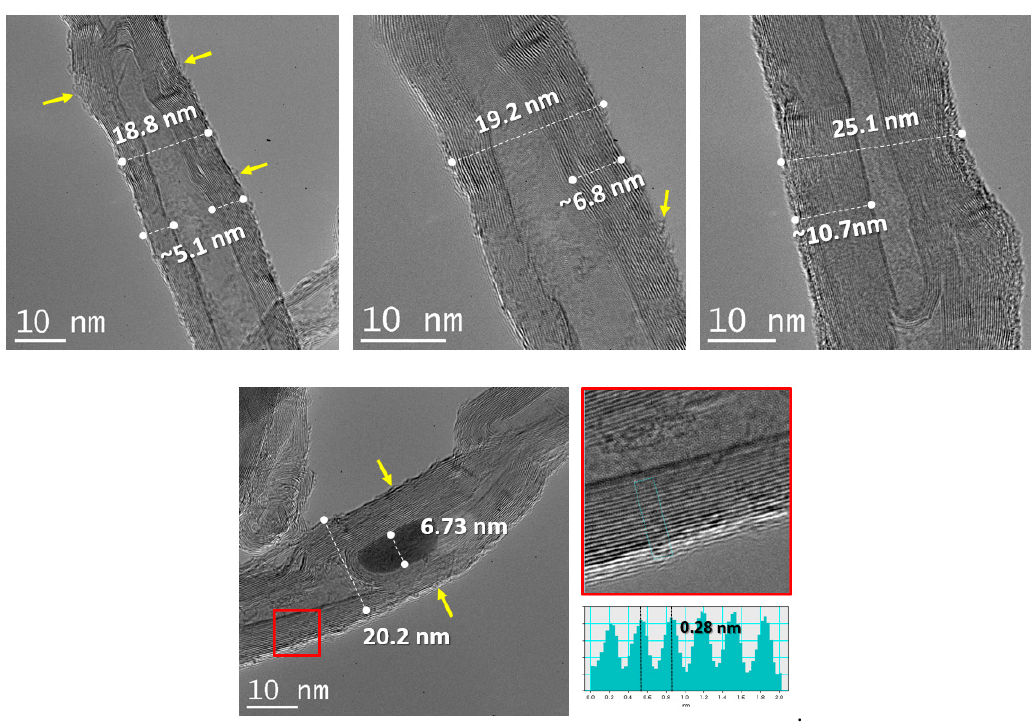
Figure 3. HR-TEM pictures of carbon nanotubes used for MWCNT/epoxy composite.